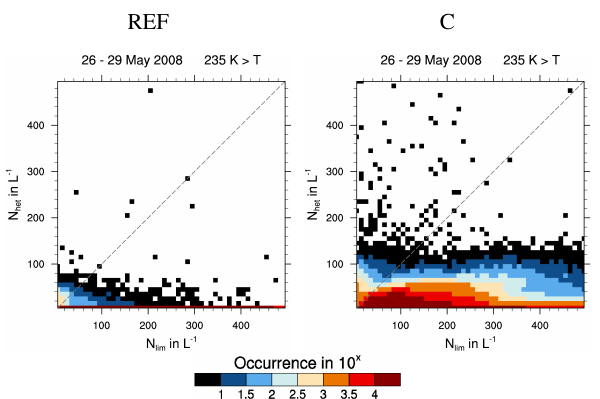
Fig. 10. Joint histogram of heterogeneously nucleated ice crystals and N lim , calculated for grid points with N d ≥ 0 . 1cm − 3 for simulation REF (left) and simulation C (right). The dashed line highlights the limit between combined heterogeneous-homogeneous freezing (below the line) and pure heterogeneous freezing only (above the line).